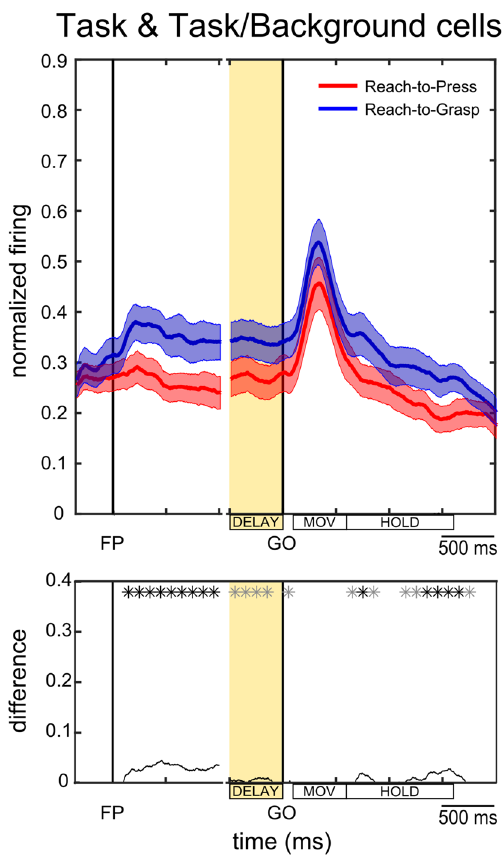
Figure 8. Pre-movement coding of reach-to-press and reach-to-grasp movements across task-selective cells. Population SDFs for the Reach-to-Grasp (in blue) and Reach-to-Press (in red) tasks are shown for all cells in the population which showed a task-related activity in the DELAY epoch (n = 47), i.e. both Task cells and Task/Background cells , as computed across background conditions and independently of single-cell task preference. The population of cells shows an overall preference for preparing a reach-to-grasp action, rather than a reach-to-press one. All conventions as in Fig.